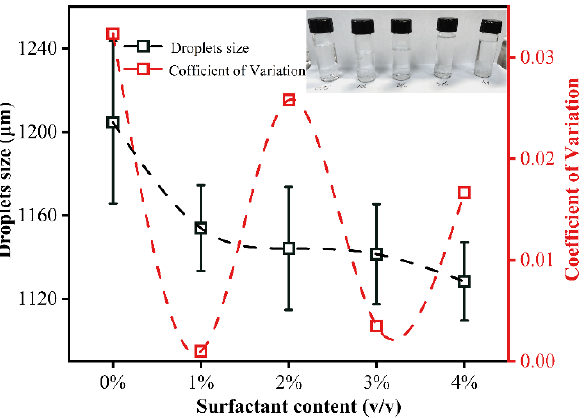
Figure 5. The variation of the content of surfactant with droplet’s size and coefficient of variation.